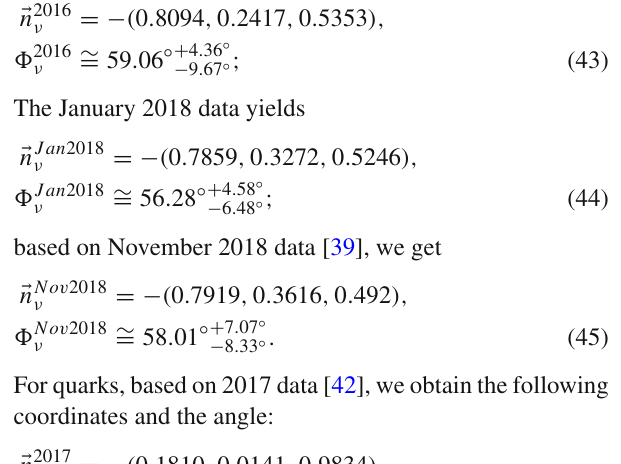
45 . 0 ◦ . So, the angle between the quark and neutrino rotation axes is relatively stable, ≈ 45 ◦ , despite the values of (cid:13) n i (cid:13) vary from year to year. For the CBM parameterization this angle = 45 . 0 ◦ (see Fig. 6, where all the axes are drawn with the opposite signs (cid:13) n → −(cid:13) n to show them in first